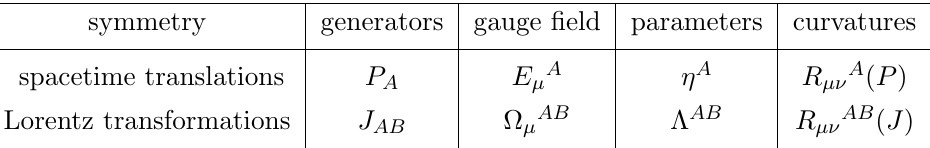
Table 1 . This table indicates the generators of the Poincar(cid:19)e algebra and the gauge (cid:12)elds, local parameters and curvatures that are associated to each of these